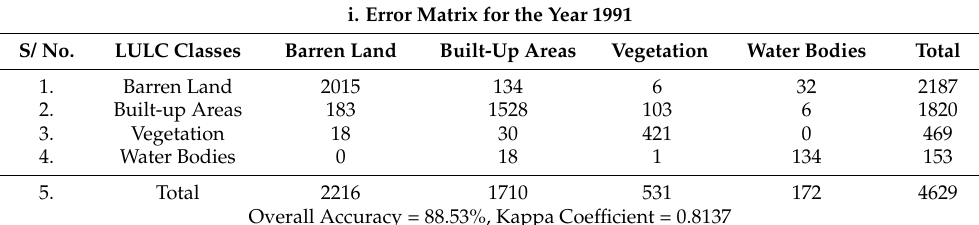
Table 4. Error/confusion matrix of the four time nodes, i.e., 1991, 2000, 2010, and 2020. i. Error Matrix for the Year 1991 S/